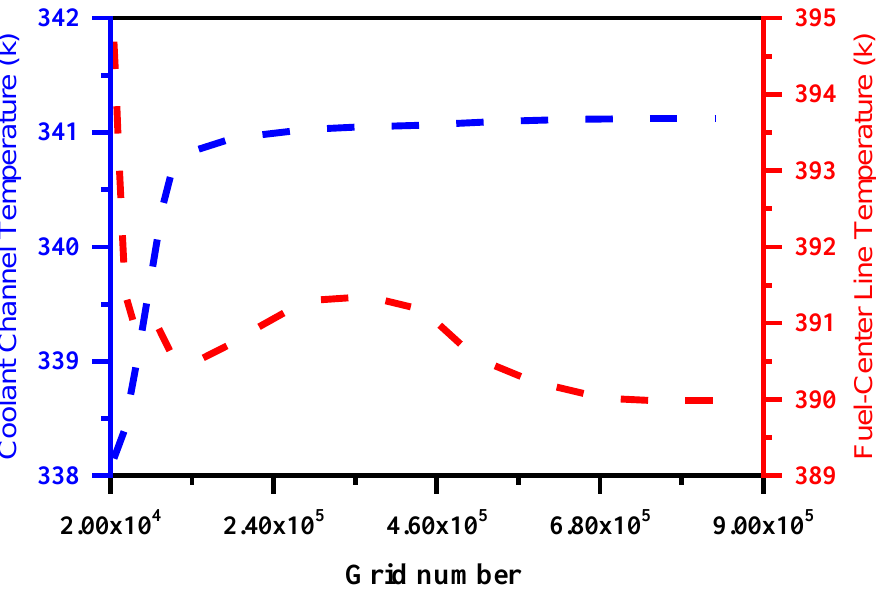
Figure 6. Evaluation of mesh sensitivity of the simulated MSTR-HPCs’ hot-channel. For better evaluation of heat transfer over a small region, the thin zirconium layer sur- rounding the fuel meat was defined as thermal contact conductance (TCC) [25].